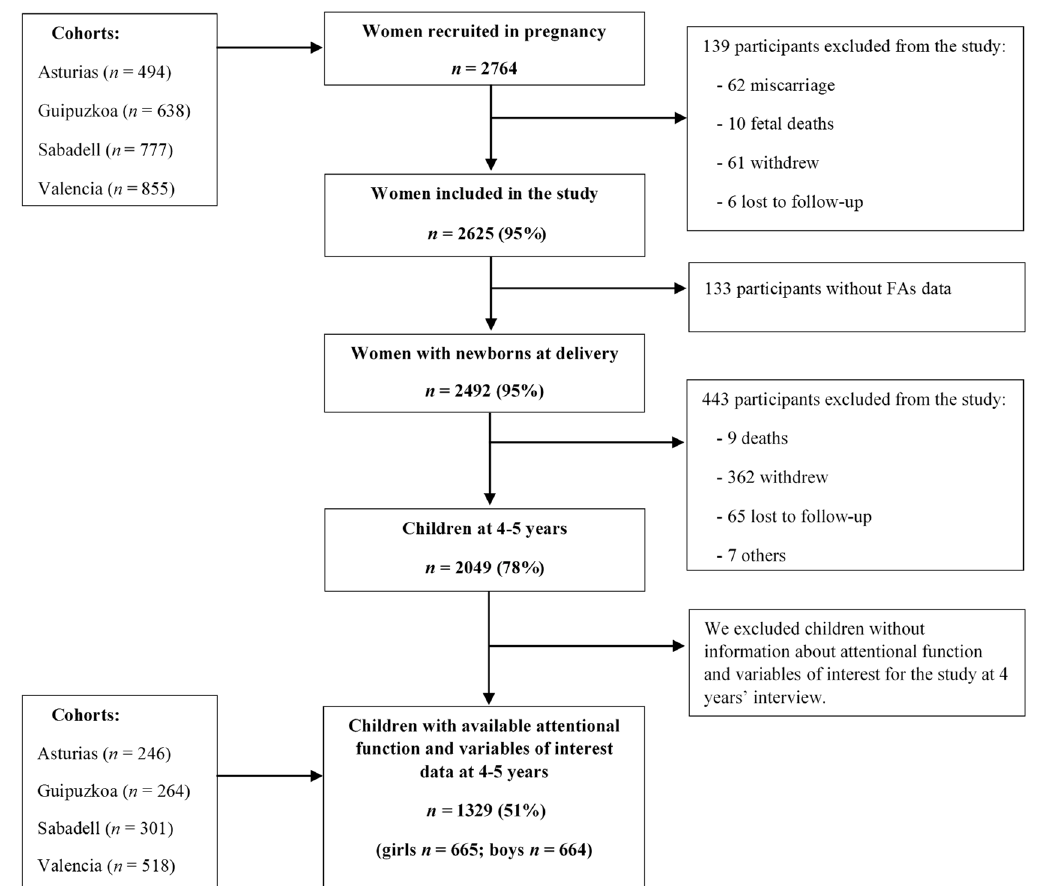
Figure 1. Flowchart of the study population describing the selection process.